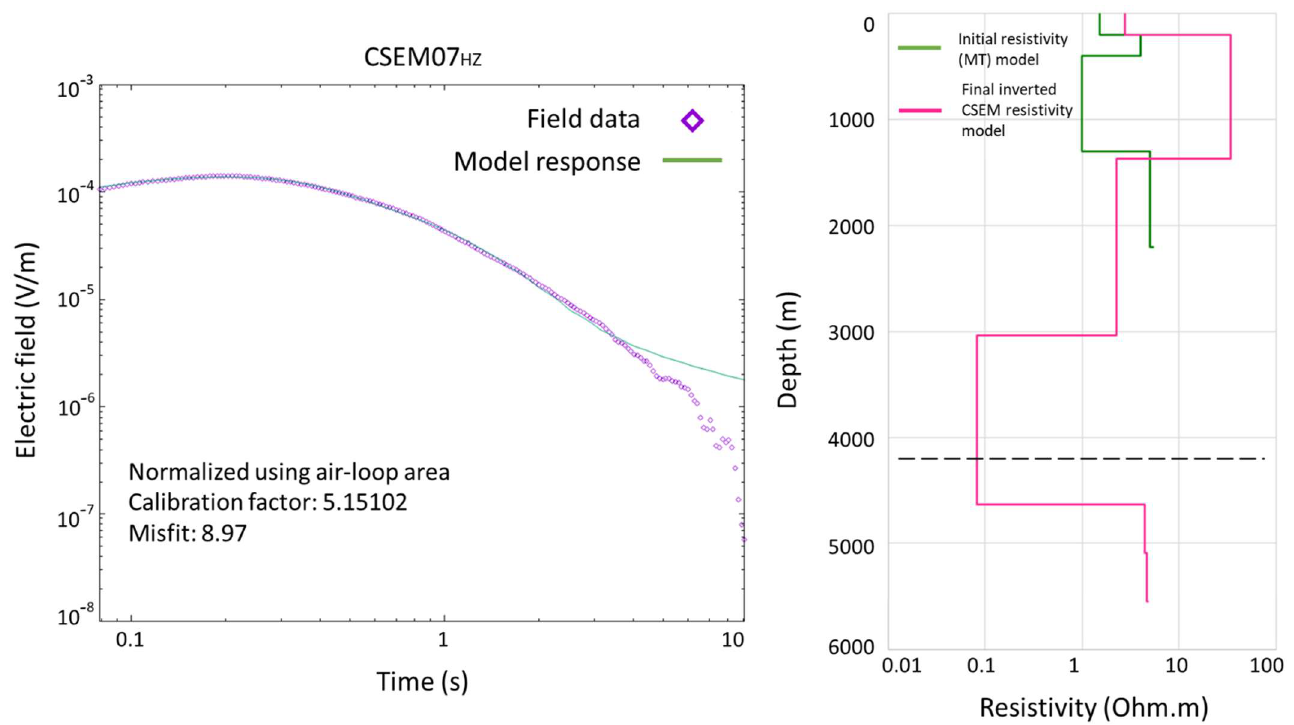
Figure 14. The final inversion results for the CSEM data were collected at ST-07. The fitting between the modeled and observed E-field is presented in the left graph. The final inverted model is shown on the right. The skin depth at 4.1 Km is shown as a dashed line.